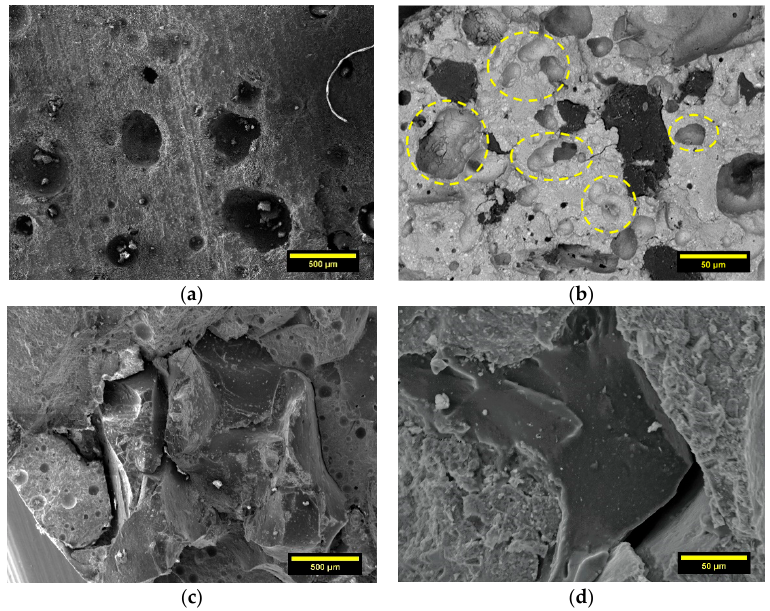
Figure 10. SEM analysis: ( a ) spheroidal pore system in CTR sample, ( b ) irregular macropores around the rubber particles in RP100 mix, ( c ) weak adhesion and porous ITZ between RG and cement paste, and ( d ) partial interfacial bonding between RP and cement matrix.